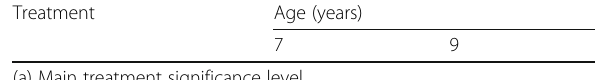
Table 8 The ANOVA summary (a) main treatment significance level and (b) volume production per treatment across three sites over time of a trial in the second and third rotation sites established in 1991 Treatment